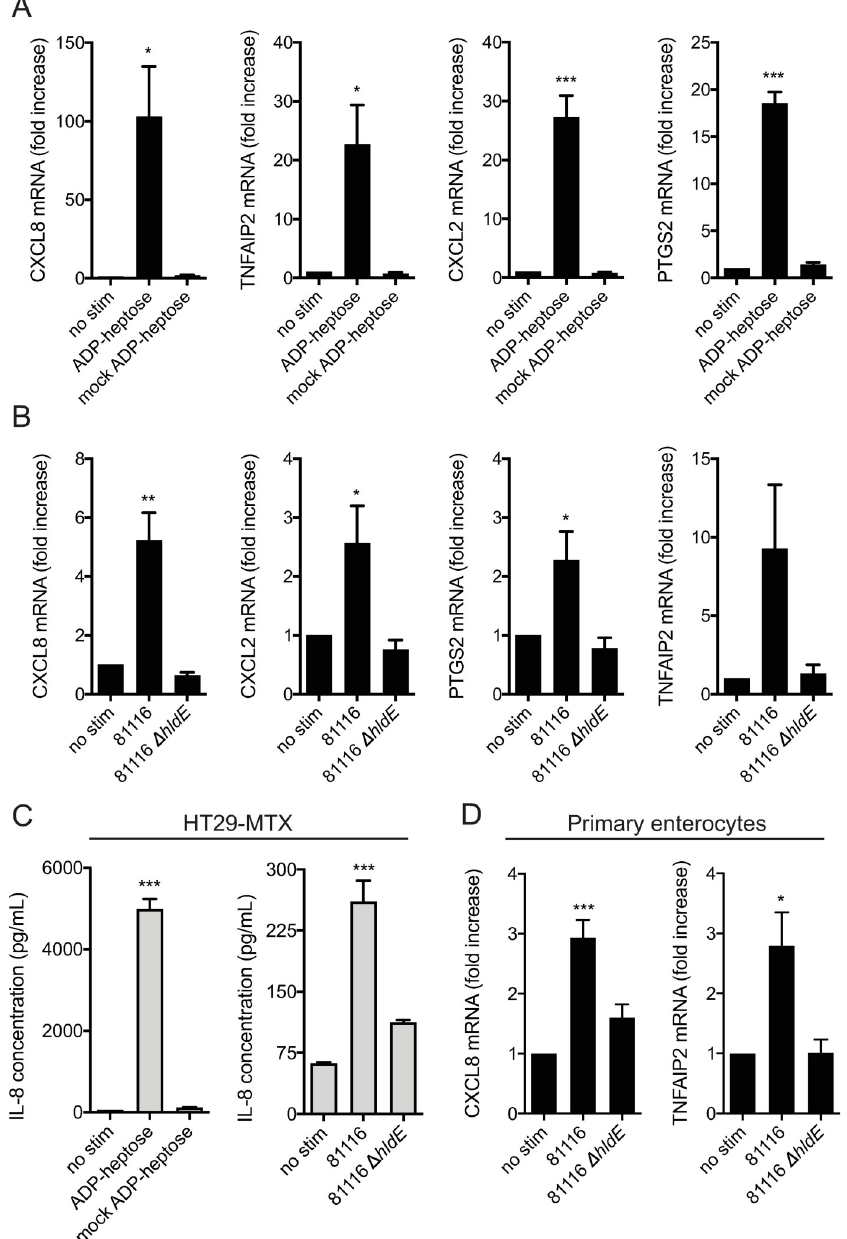
Fig 7. C . jejuni ADP-heptose activates inflammatory responses in human intestinal epithelial cells. Intestinal HT29-MTX cells were (A) stimulated for 3 h with in vitro synthesized ADP-heptose or mock reactions (mock ADP- heptose), or (B) infected for 10 h with washed viable C . jejuni 81116 or C . jejuni 81116 Δ hldE at a multiplicity of infection of 200 after which mRNA expression of CXCL8 , TNFAIP2 , CXCL2 and PTGS2 was determined by qPCR. (C) HT29-MTX cells infected for 18 h with washed viable C . jejuni 81116 or C . jejuni 81116 Δ hldE at a multiplicity of infection of 200 after which IL-8 concentrations were measured using ELISA. (D) Ex-vivo primary enterocytes were infected for 10 h with washed viable C . jejuni 81116 or C . jejuni 81116 Δ hldE at a multiplicity of infection of 200 after which mRNA expression of CXCL8 and TNFAIP2 was determined by qPCR. Data are presented as fold change in transcript levels between stimulated versus unstimulated cells. IL-8 secretion is depicted as pg/ml after correcting for background. Values represent the mean ± SEM of three independent experiments performed in duplicate. � p < 0.05, �� p < 0.01, and ��� p <